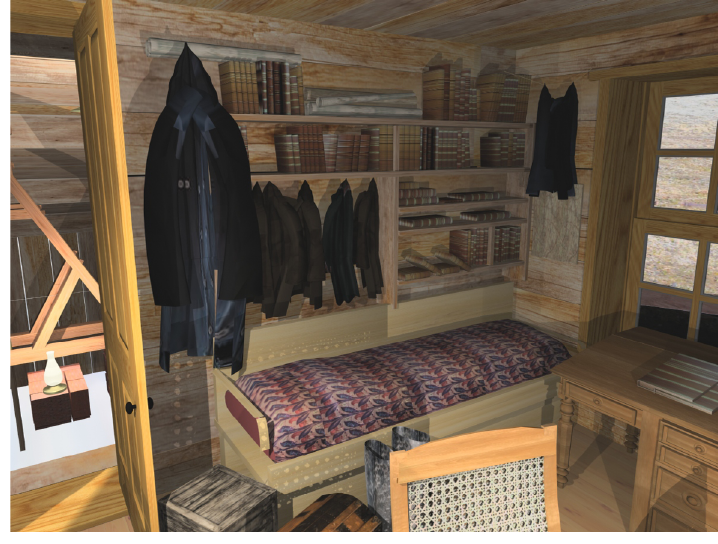
Figure 19. The corresponding computer reconstruction of Lockwood’s